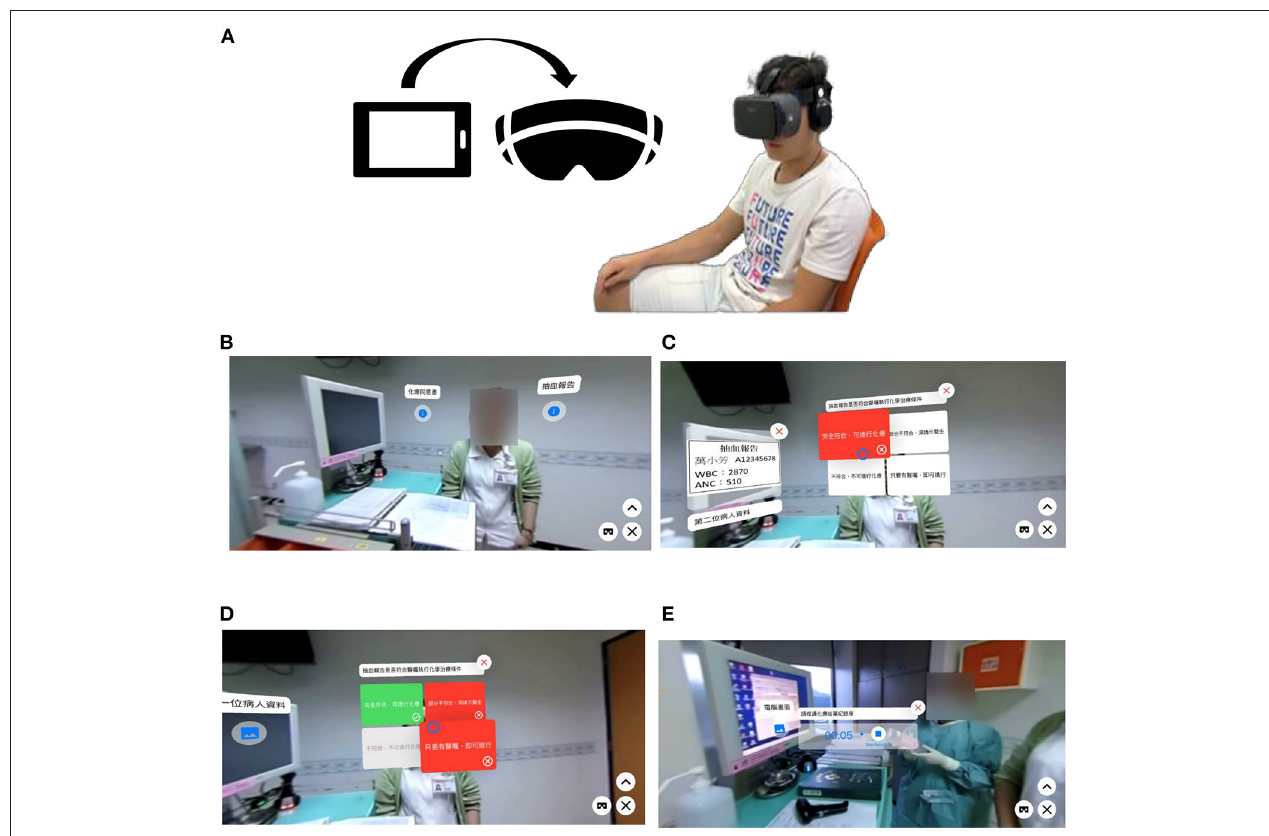
FIGURE 2 | Educational content and environment settings for the VR group. (A) Smartphone and VR goggles; (B) Before chemotherapy, you can use the select button to view the contents of the documents that need to be confirmed; (C) Check the blood draw report to see if chemotherapy can be performed. If the wrong selection is made, the next step cannot be performed; (D) If the correct answer is selected, proceed to the next step; (E) To practice and to record the double check medication